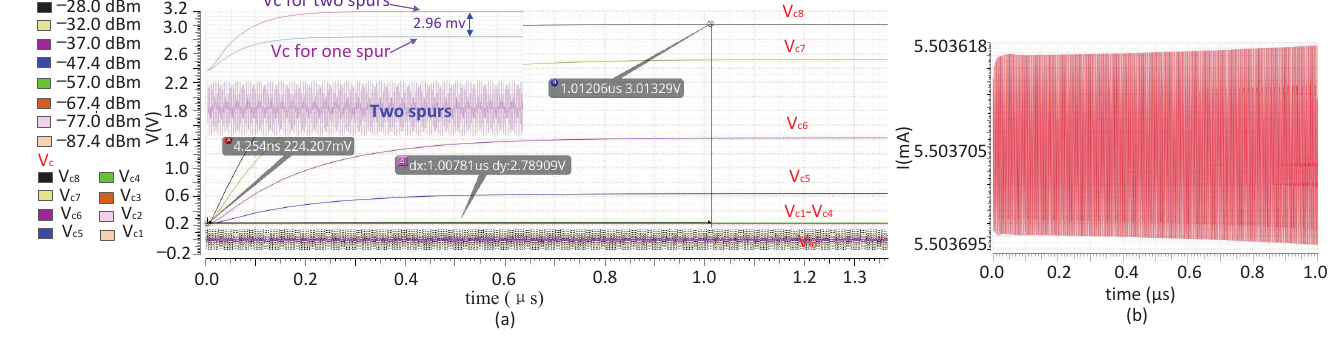
Figure 4. The simulation of the spur detector: ( a ) output signal V c of the LPF corresponds to the input spurs V in of different amplitudes, ( b ) dynamic operating current when the frequency of V in is about 400